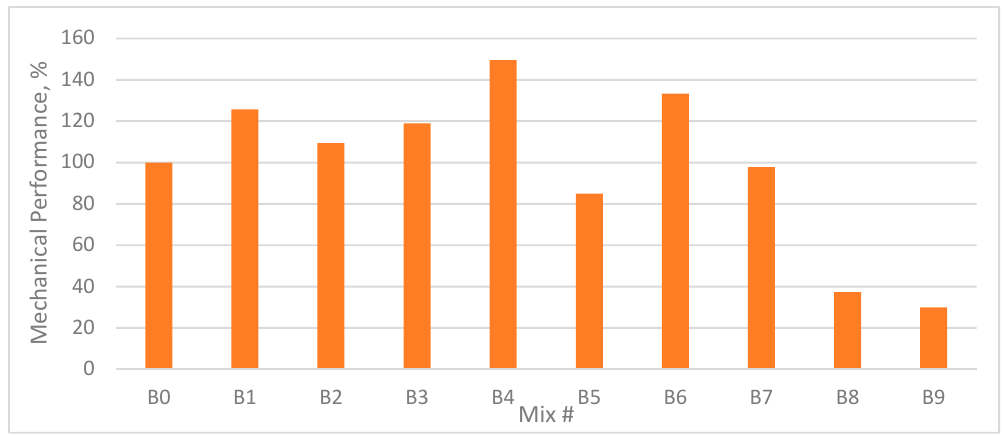
Figure 12. Mechanical performance of each mixture with respect to control mix (B0) with W/B 0.35.